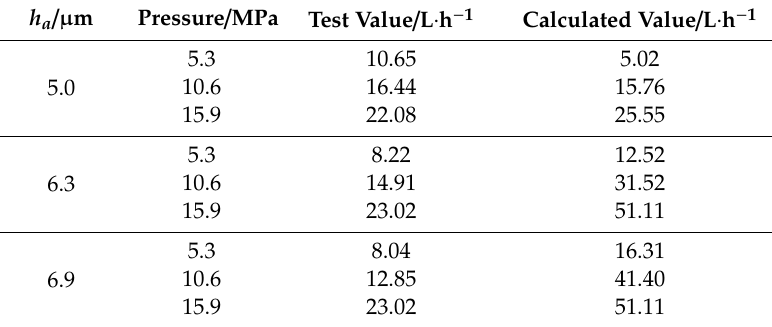
Table 3. Calculation and test results comparison at the di ff erent